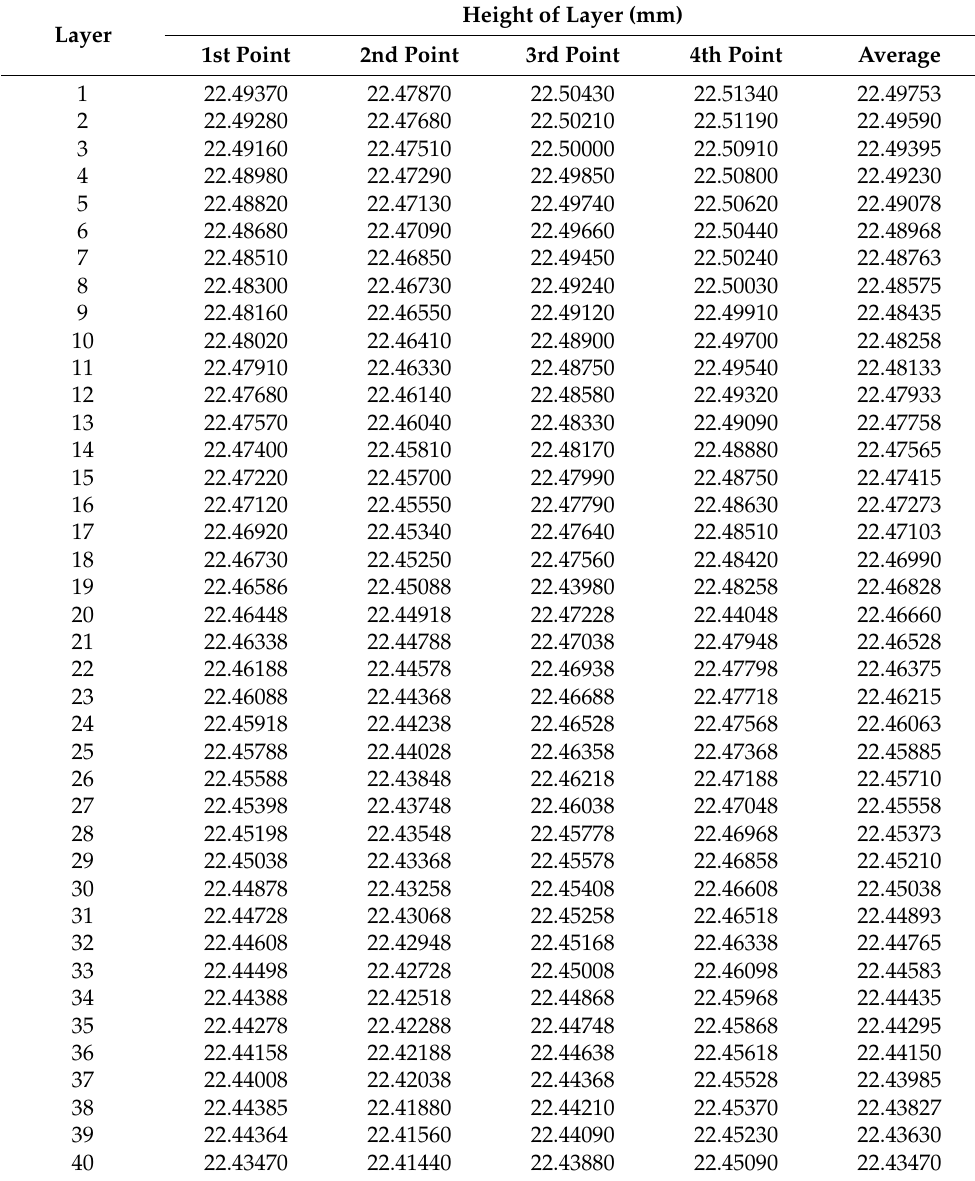
Table 1. Height of the polished sample at each